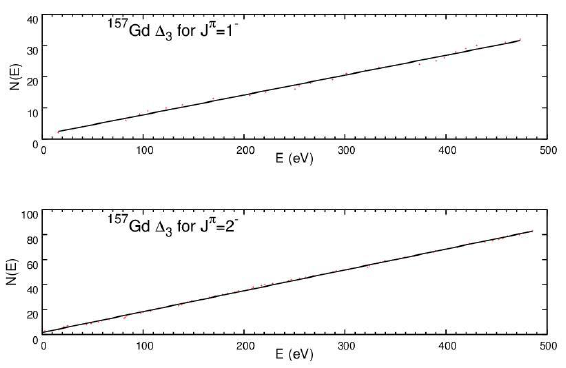
Fig. 9. Cumulative number of energy levels in the energy 0 eV to 500 eV for 157 Gd.